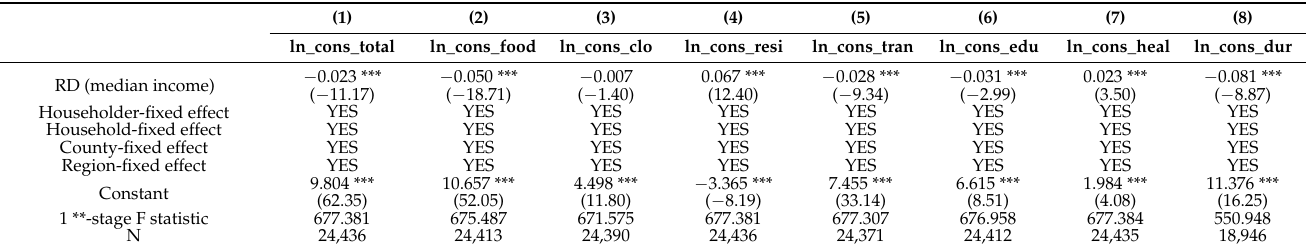
Table 6. Results of the robustness test (median income): IV model.